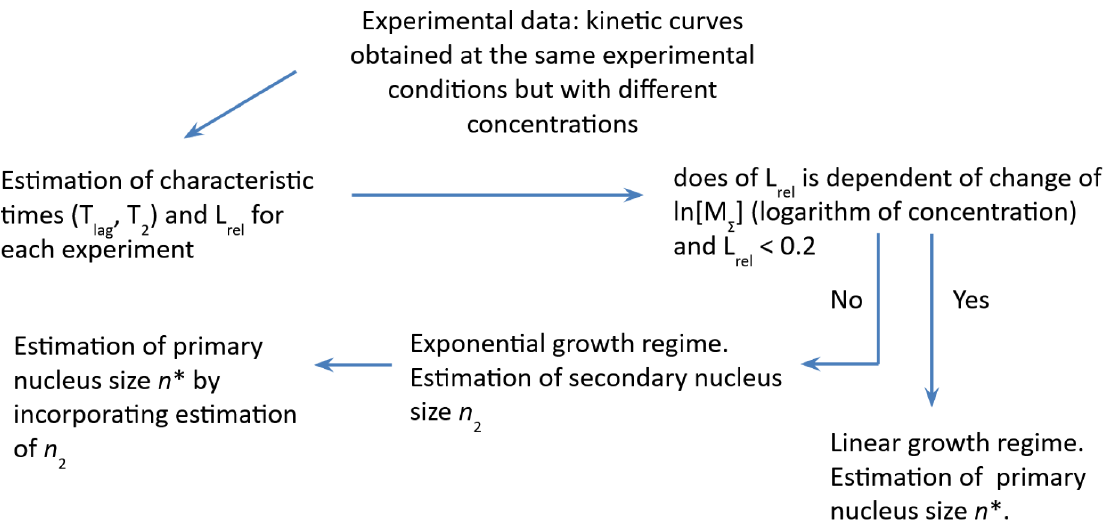
Figure 3. General scheme of experimental data analysis of kinetics of amyloid fibril